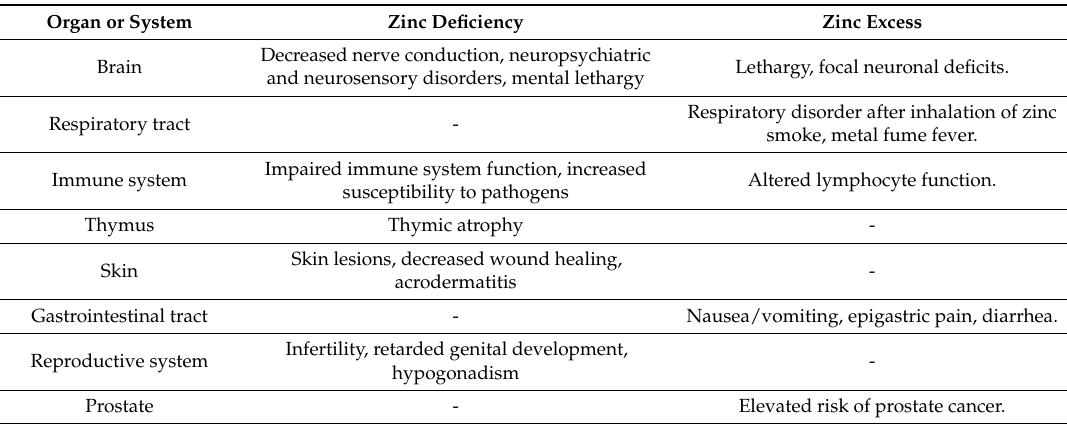
Table 2. The systemic symptoms resulting from zinc deficiency and excess